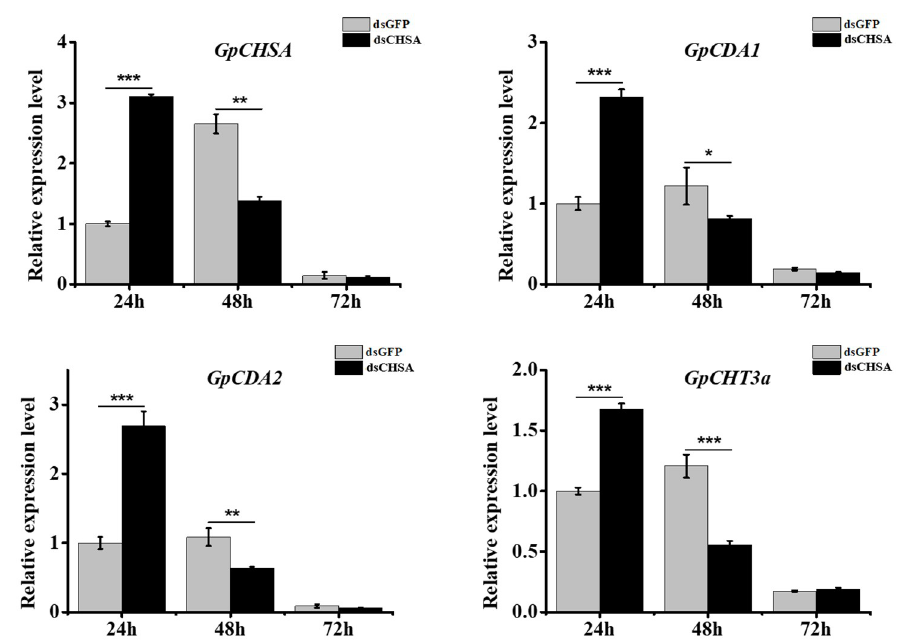
Figure 5. The analysis of expression patterns of GpCHSA and its downstream genes post-injection with dsCHSA in the integument at di ff erent times using RT-qPCR. GpRpl32 was used to normalize the data that are showed as mean ± standard error, the mean is the triple independent repeats. The 2 − ∆∆ C t method was adopted to calculate the relative expression level. Di ff erences among triple repeats were analyzed using one-way analysis of variance (Systat, Inc., Evanston, IL) with Tukey’s post-hoc test using R version 4.0.0. Asterisks represent the significant di ff erence, as follows: * p < 0.05; ** p < 0.01; *** p < 0 .001.